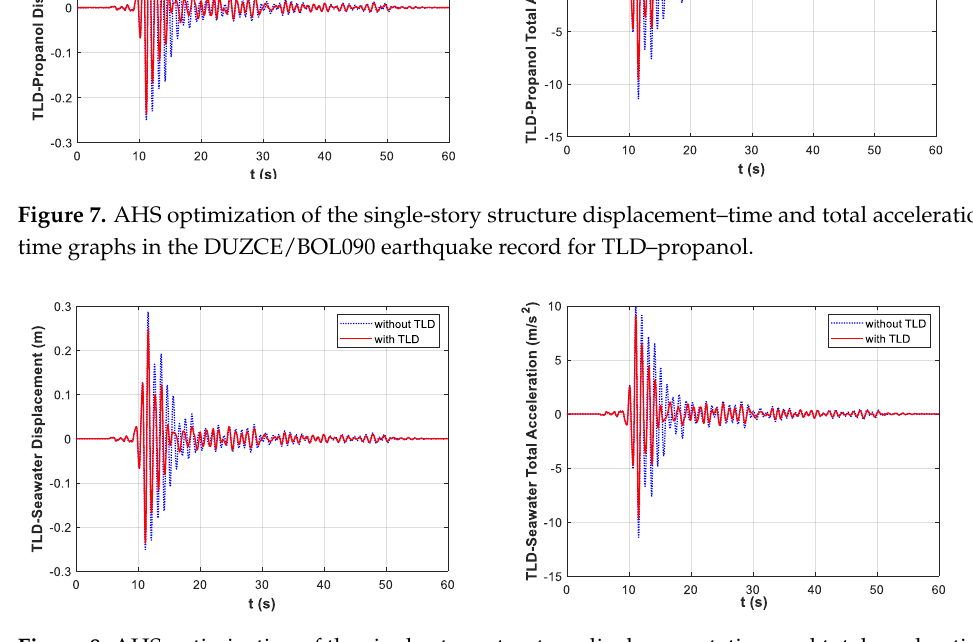
Figure 8. AHS optimization of the single-story structure displacement – time and total acceleration – time graphs in the DUZCE/BOL090 earthquake record for TLD – seawater.